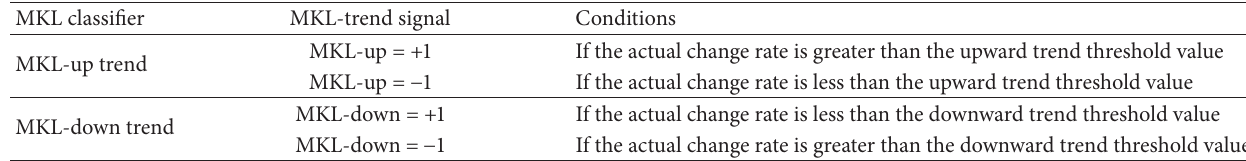
Table 2: Output labels for MKL up-trend and down-trend classifiers.